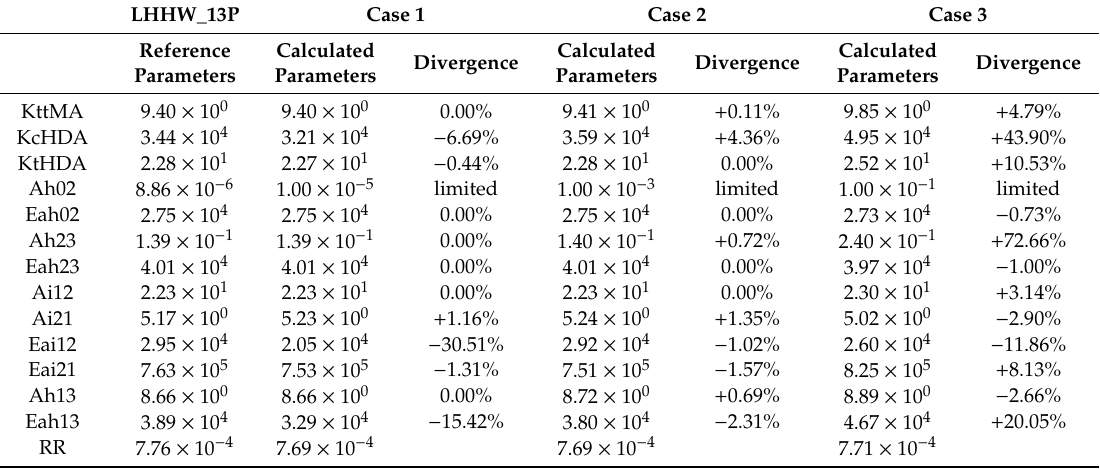
Table 3. Sensitivity analysis performed on the constrained regression increasing the lower